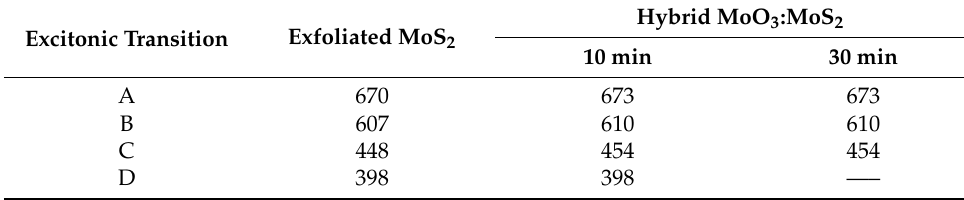
Figure 10. Absorbance spectra of exfoliated MoS 2 (blue line) and MoO 3 :MoS 2 dispersion as function of reaction durations of 10 min (pink line) 30 min (orange line). Table 4. Positions of the excitonic